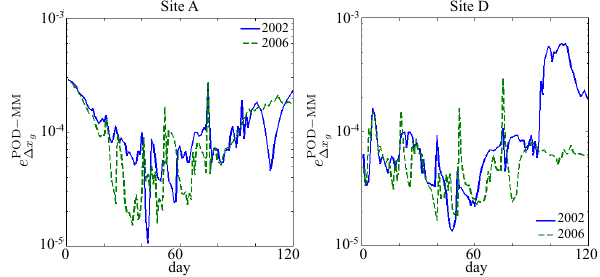
) in 2002 and 2006 at sites Figure 8. The POD-MM error ( e POD - MM 1x g A and D for single-site ROM constructed using POD-MM method. Figure 9. Solutions of f , g , and ε POD - MM for day 1 for year 2002 1x g at site A and for three soil depths; the top, middle, and bottom rows correspond to layers 0–5, 20–25, and 45–50cm, respectively, from the surface.